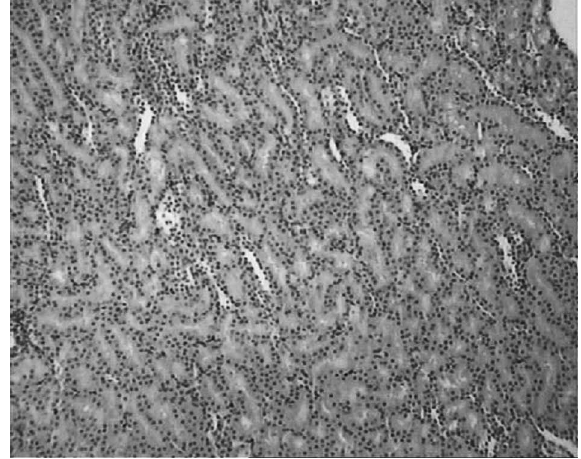
FIG. 1. Light micrograph of the corticomedulary region of a rat kidney from the control group. Normal histology (hema- toxylin and eosin, (cid:4) /